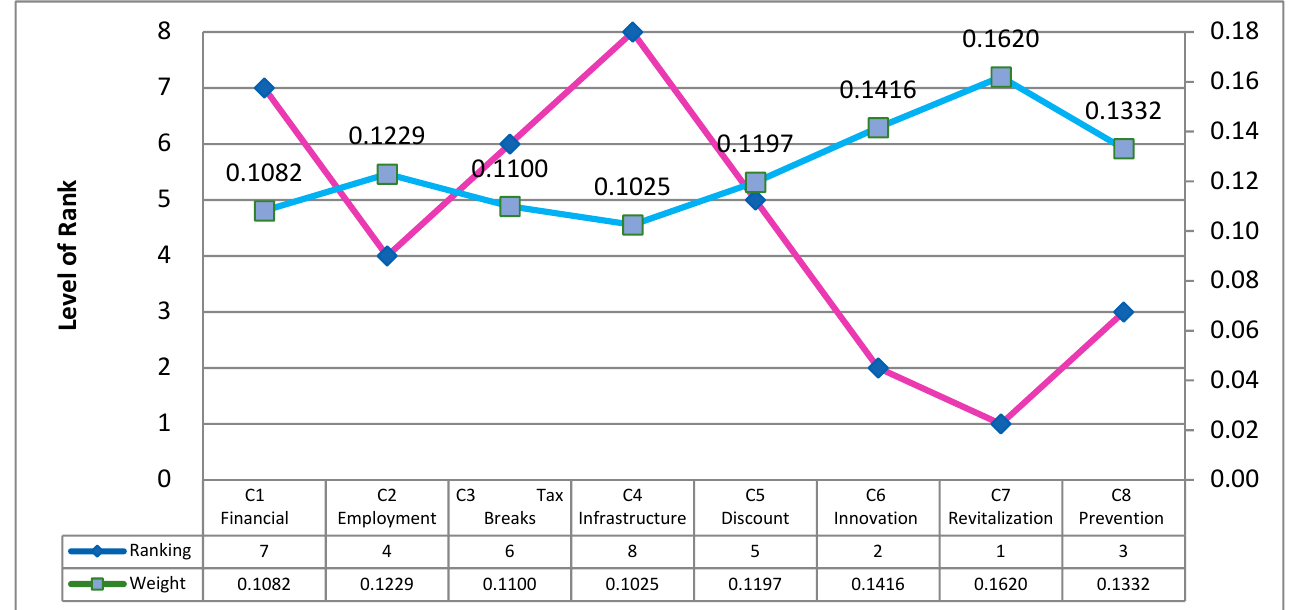
Figure 3. Rank of priority weight and influential criteria of evaluators. According to Figure 3. the ranking of the main criteria is 𝐶